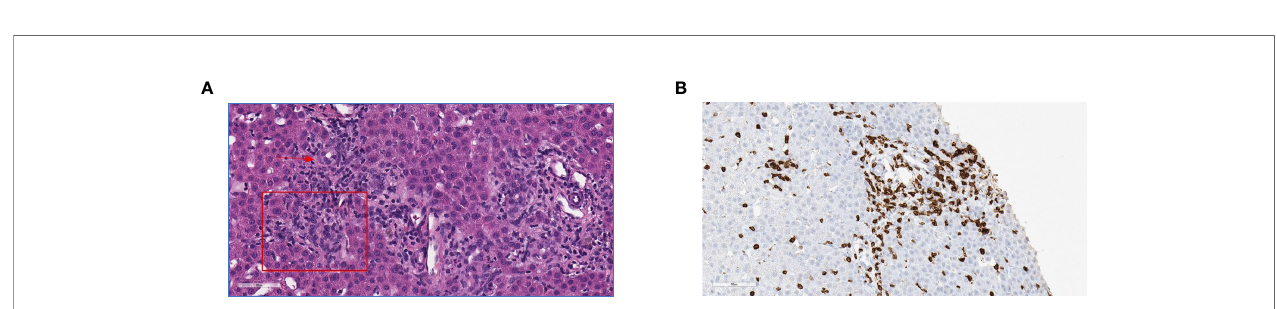
FIGURE 3 | Histopathology of liver graft-versus-host disease. (A) H&E stain showing predominantly portal lymphoplasmacytic in fi ltration disrupting the interface (square) expanding two adjacent portal zones; arrow to interlobular bile duct. (B) CD3 Immunochemistry showing T cell lymphocytic in fi ltrates in the epithelium of the bile duct, lymphocytic in fi ltrates predominantly in the portal tracts with associated interlobular bile duct injury.